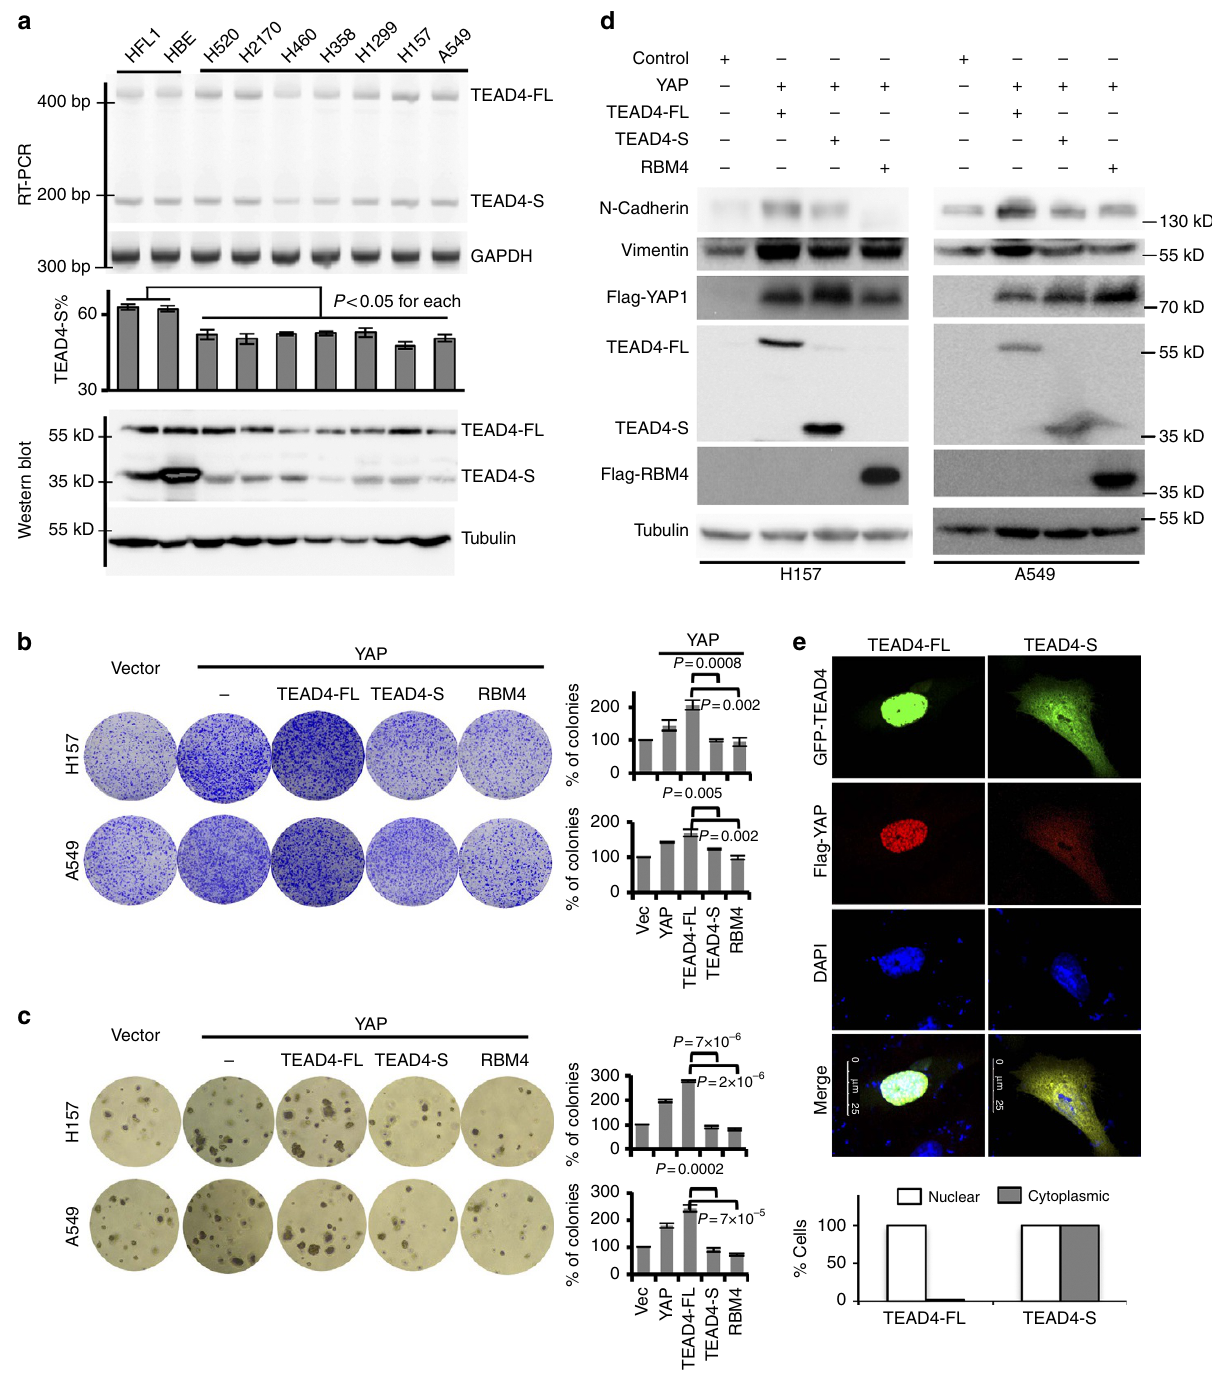
Figure 3 | TEAD4-S reduces cancer cell proliferation and EMT. ( a ) RNA levels (upper panel) and protein levels (lower panel) of TEAD4-S in various NSCLC lines and normal bronchial cells were measured by semi-quantitative RT–PCR and western blot. The mean ± s.d. for the percentage of TEAD4-S mRNA was plotted from three experiments. Each cancer cell line was compared with the two normal cell lines to calculate P values using Student’s t -test. ( b ) H157 or A549 cells stably expressing YAP, YAP/TEAD4-FL, YAP/TEAD4-S, YAP/RBM4 or vector control were analysed by colony formation assay. All experiments were performed in triplicates, with mean ± s.d. of relative colony numbers plotted ( P values from t -test). Images of the whole plate were shown. ( c ) H157 or A549 cells stably expressing YAP, YAP/TEAD4-FL, YAP/TEAD4-S, YAP/RBM4 or vector control were analysed by soft agar assay. All experiments were performed in triplicates, with mean ± s.d. of relative colony numbers plotted ( P values from t -test). ( d ) Western blot of epithelial and mesenchymal markers was performed using lysates from indicated H157 and A549 stable cells. ( e ) The subcellular localizations of TEAD4-FL or TEAD4-S with YAP. Cells were co-transfected with Flag-tagged YAP (red) and GFP-fused TEAD4 (green), and visualized with immunofluorescence assay. Scale bar, 25 m m. The localization of TEAD4-FL and TAD4-S was quantified in transfected cells, and the per cent of cells with nuclear or cytoplasmic TEAD4 were plotted ( 4 50 cells were captured and quantified in both